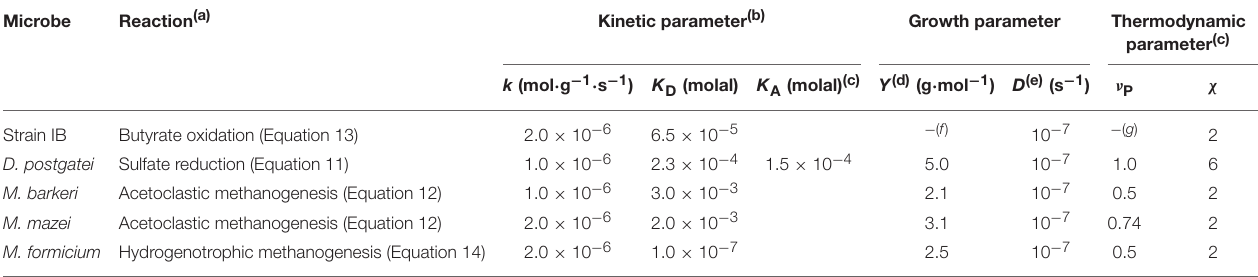
TABLE 1 | Kinetic parameters (rate constant k , and half-saturation constant K D and K A ), growth parameters (growth yield Y and specific maintenance rate D ), and thermodynamic parameters (ATP yield ν P and average stoichiometric number χ ) of microbial metabolism.